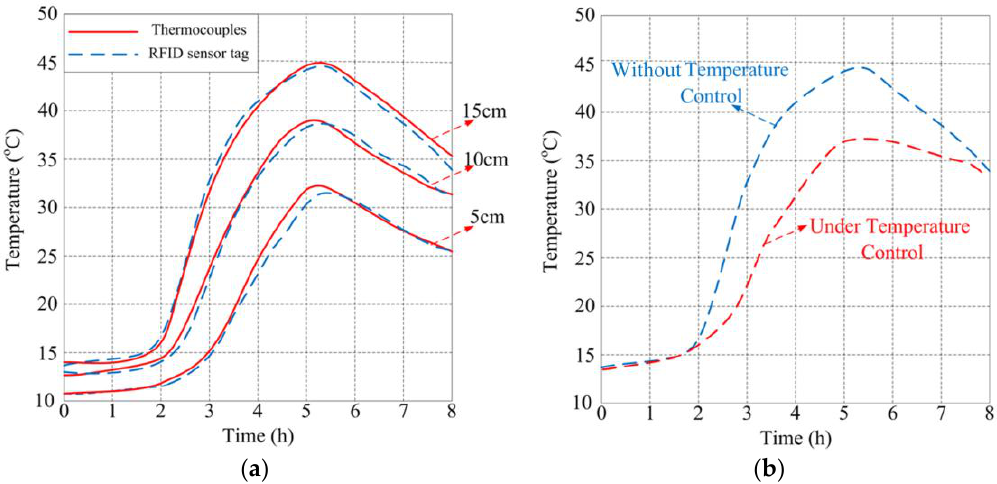
Figure 14. Temperature performance measurement of concrete: ( a ) measured internal temperature of concrete versus time in two different ways; and ( b ) comparison between testing under temperature control and without temperature control.